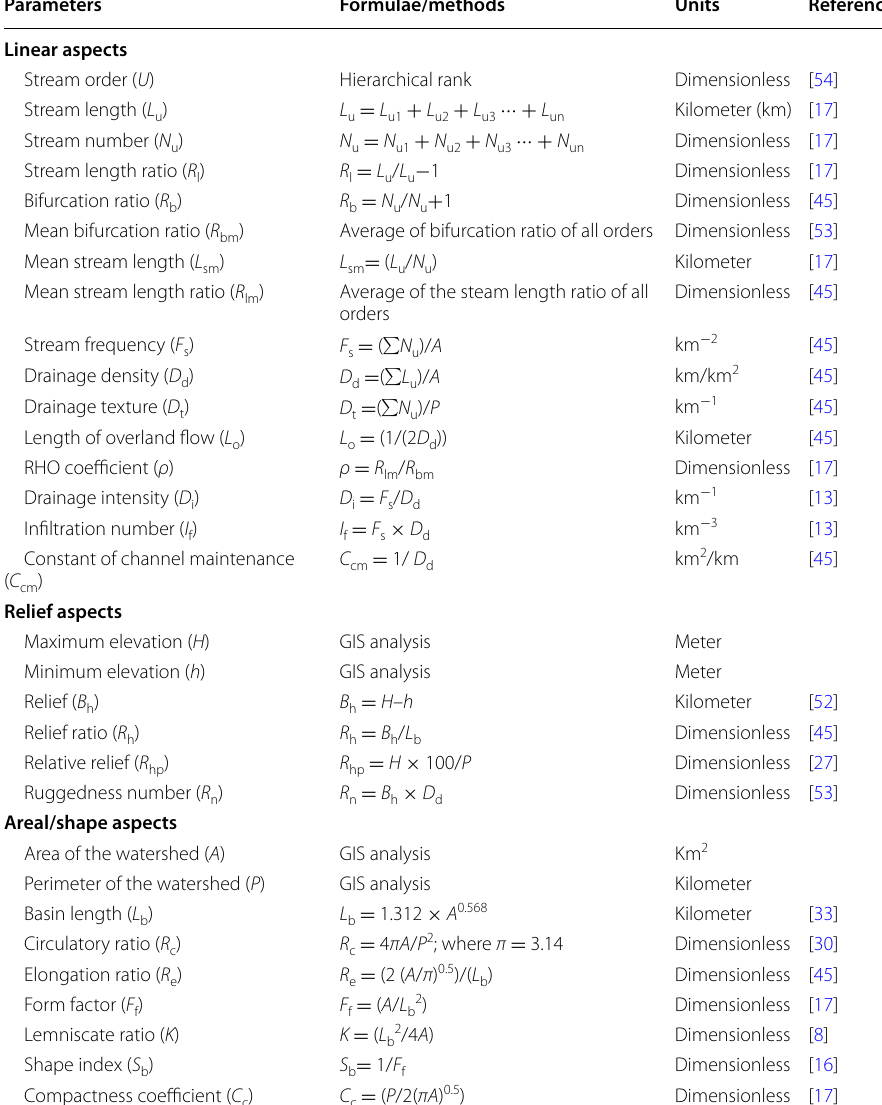
Table 2 Morphometric parameters of the Murredu